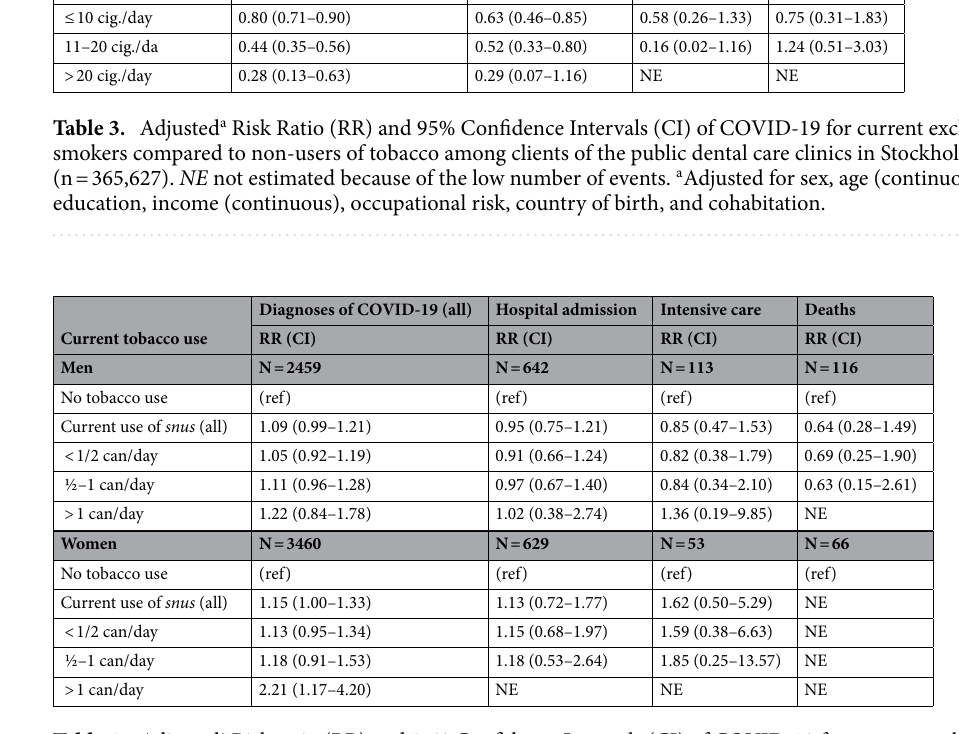
The association between smoking and COVID-19 (all diagnoses and hospital admissions) was in the same direction as described in Table 3 in both time periods (up to May 31 or from 1 June 2020 on), although somewhat stronger during the early phase of the pandemic (Supplementary material Table S4). The associations in Table 3 were virtually the same among individuals whose occupation entailed high or low-moderate risk of infection, respectively (Supplementary material Table S5). Smoking was equally associated with a lower risk of any diagnosis and of hospital diagnosis with COVID-19 among individuals with or without previous diagnoses of chronic diseases causally associated with tobacco use